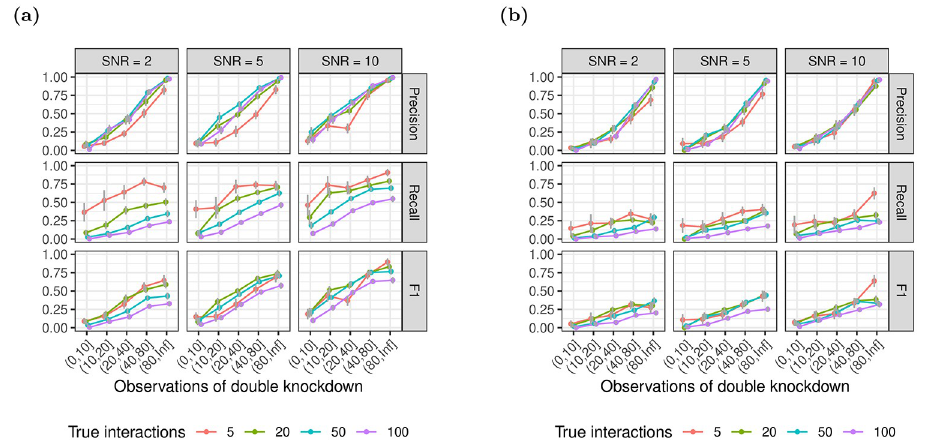
Fig 3. Identification of epistasis for increasing numbers of observations of the pairwise double knockdown. The number of additional main effects not overlapping with the set of interacting genes is fixed to 20. Results using (a) glinternet and (b) xyz .